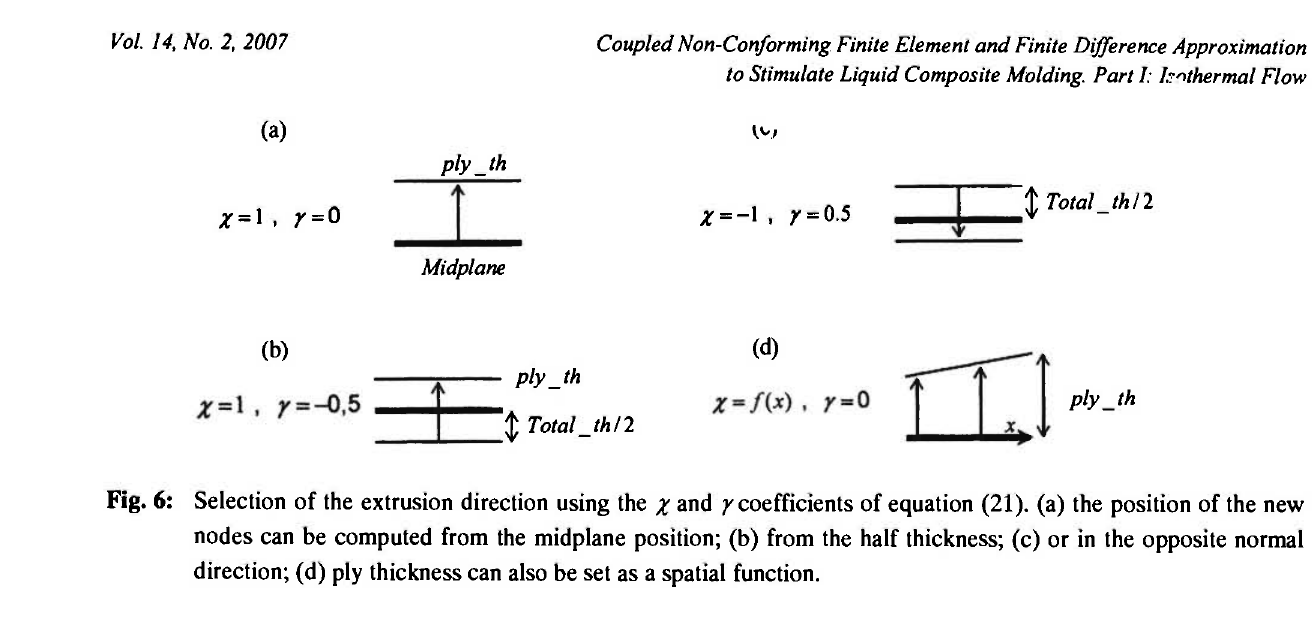
Fig. 6: Selection of the extrusion direction using the χ and ρ coefficients of equation (21). (a) the position of the new nodes can be computed from the midplane position; (b) from the half thickness; (c) or in the opposite normal direction; (d) ply thickness can also be set as a spatial function.